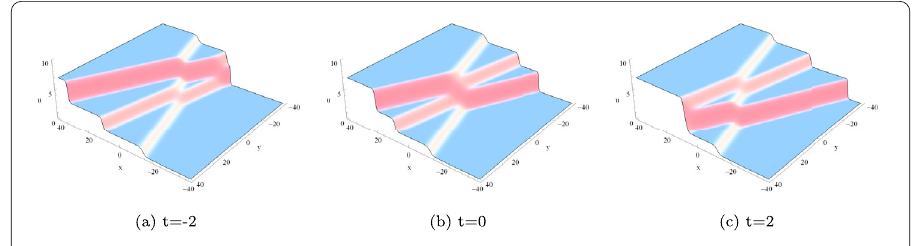
Figure 1 Interaction of three solitons for the BKP-II equation with parameters